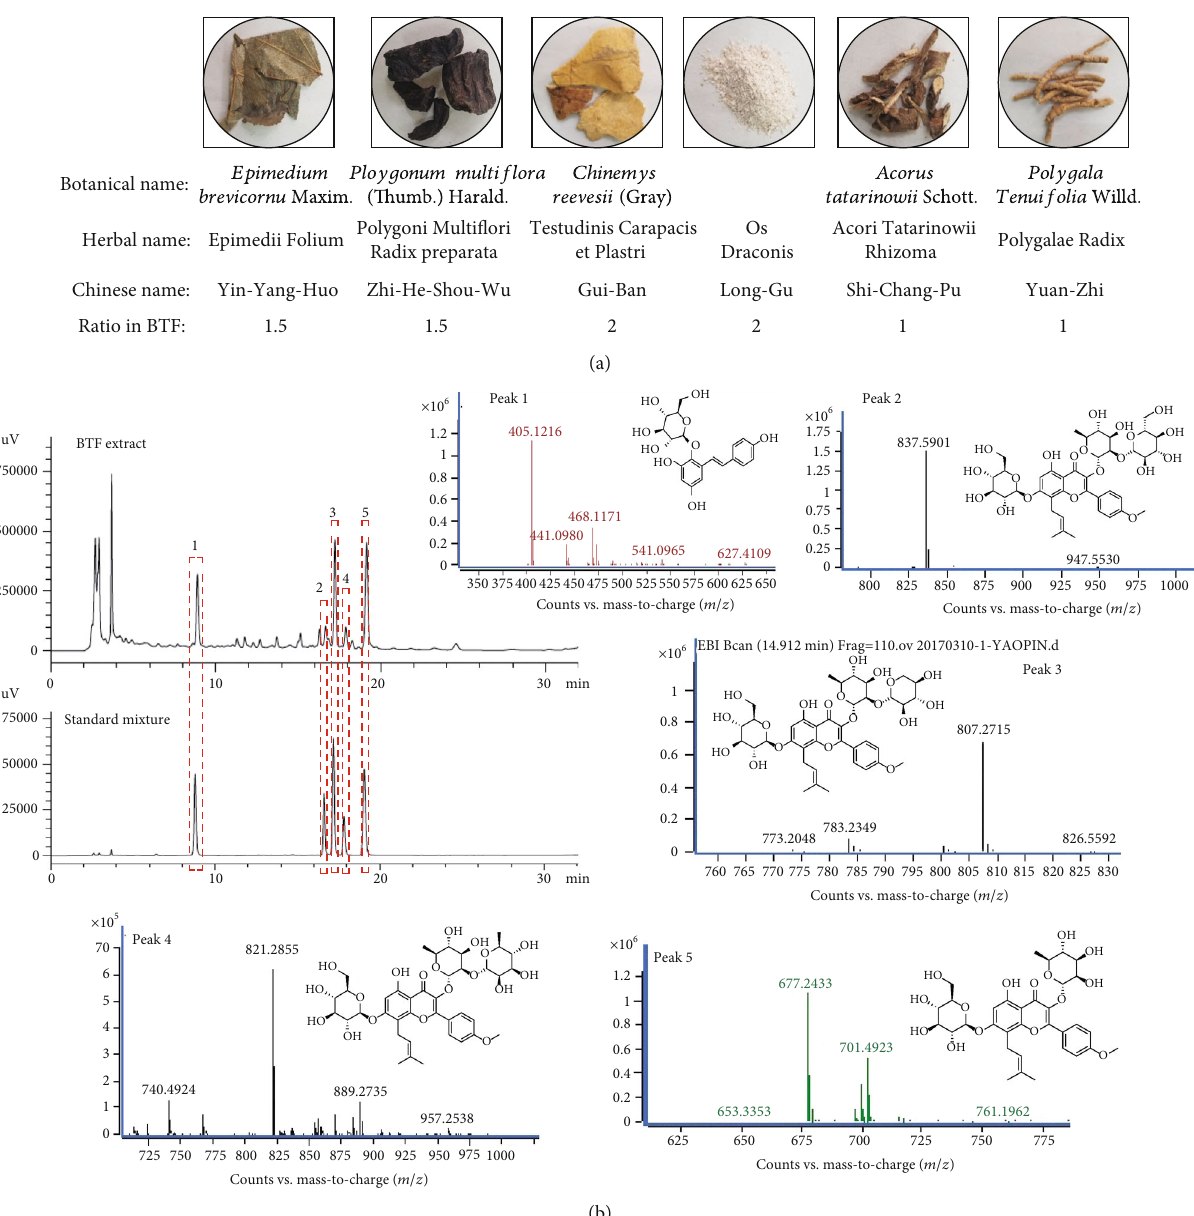
Figure 1: Herb information and chromatographic fi ngerprinting of the Bushen-Tiansui Formula (BTF). (a) Representative fi gures, herbal names, and Chinese names and the ratio of the corresponding herbs in BTF. (b) Chromatograms of BTF and a standard mixture, as well as m / z ratio and structure information of peaks 1-5 in the BTF chromatogram. Peak 1: stilbene glycoside; peak 2: epimedin A1; peak 3: epimedin B; peak 4: epimedin C; peak 5: